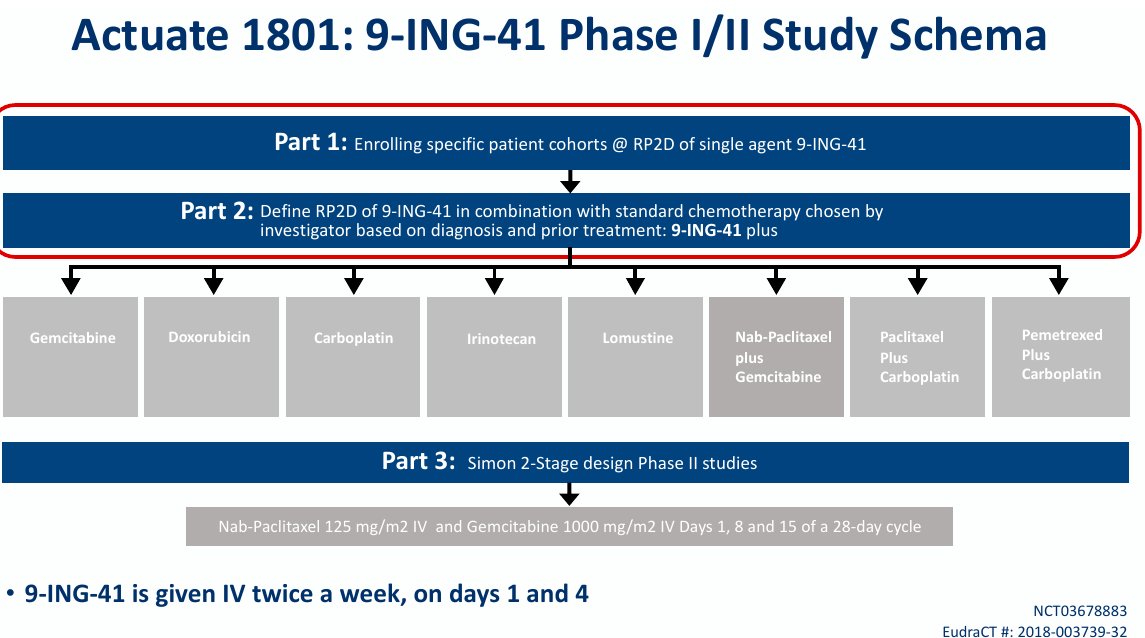
Figure 1. Trial design of the Actuate 1801 trial. The objectives of the ongoing Part 1 and Part 2 are to determine the recom- mended phase II dose (RP2D) of 9-ING-41 with and without chemotherapy, respectively. The choice of the chemotherapy agent will be chosen by the investigator and depend on the diagnosis and prior treatment. Part 3 will be a Simon 2-stage phase II design which is an expansion cohort that will open based on the results of Part 1 and 2. It will evaluate 9-ING-41 with gemcitabine with nab-paclitaxel in advanced pancreatic ductal cancer (PDAC) for first-line